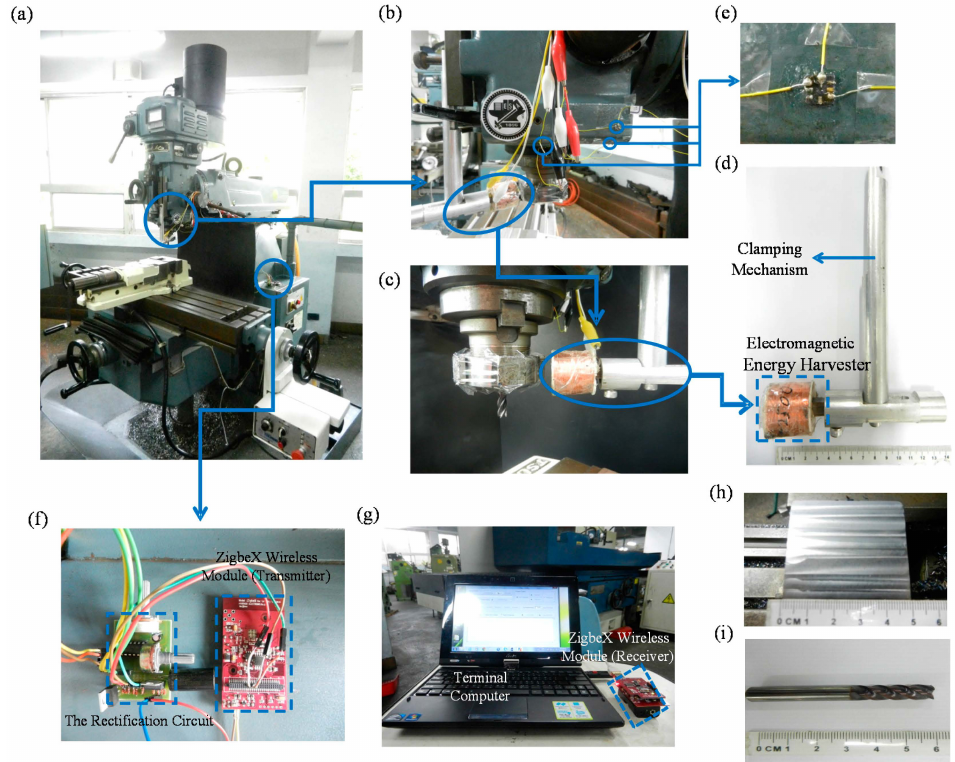
Figure 3. Photographs of the fabrication and testing: ( a ) test setup; ( b ) and ( c ) enlarged view of the locations of the electromagnetic energy harvester and MEMS accelerometers; ( d ) and ( e ) enlarged view of the harvester and accelerometers; ( f ) enlarged view of both the wireless chip module (used as the transmitter) and the rectification circuit; ( g ) wireless chip module (used as the receiver) and the terminal computer; ( h ) top view of the work piece; ( i ) milling